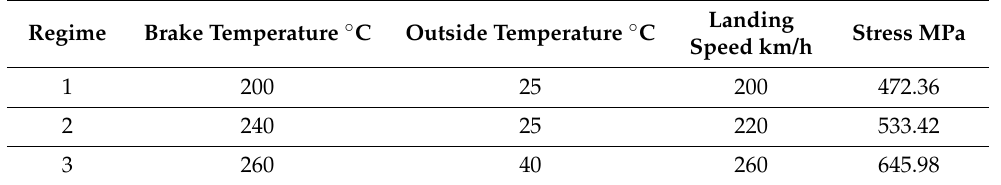
Table 2. Inputs for the neural network.